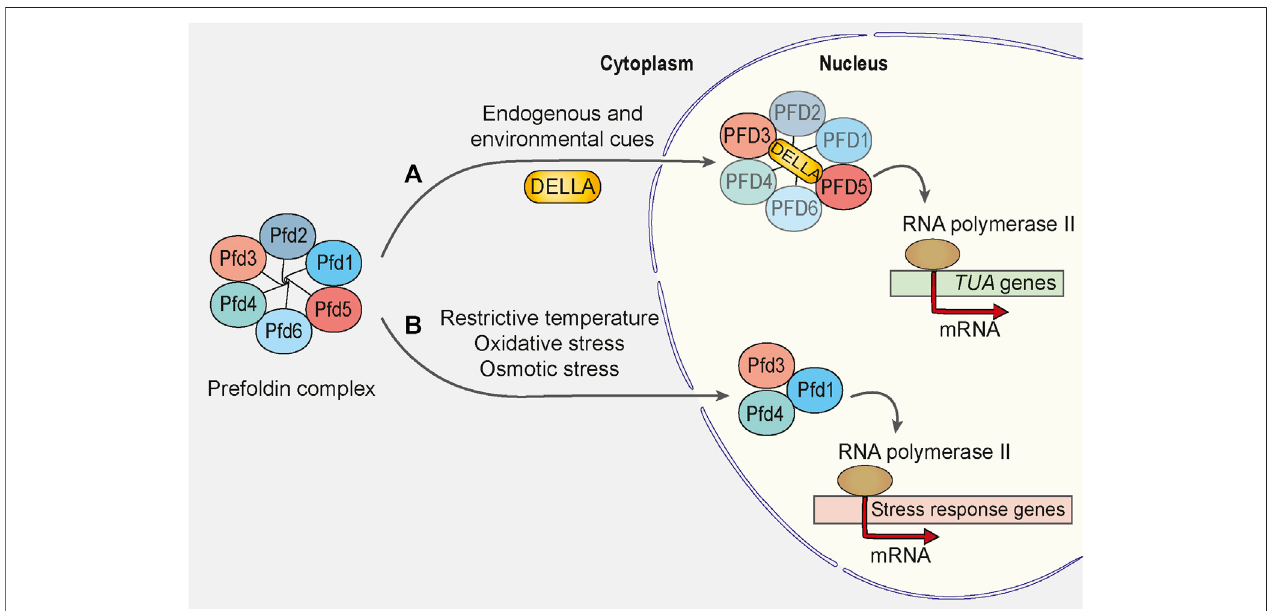
FIGURE 3 | Prefoldin complex is involved in transcriptional regulation upon cellular stress. (A) In Arabidopsis , endogenous and environmental stimulators control the growth rate of a plant by inducing the DELLA-mediated accumulation of prefoldin complex in the cell nucleus. PFD3 and PFD5 interact directly with DELLA, but integrity of the prefoldin complex during the translocation remains unaffected. In the nucleus, prefoldin complex or some of its subunits activate the transcription of α - tubulin encoding genes ( TUA ). (B) In response to exposure of yeast Saccharomyces cerevisiae to stress stimuli such as restrictive temperature, oxidative and osmotic stress, Pfd1, Pfd3 and Pfd4 subunits localize to the nucleus to facilitate the transcription elongation of some stress-response genes. Pfd1, Pfd3 and Pfd4 may formadistinctcomplexfromthehexamericprefoldincomplexbecausetheabsenceofotherprefoldinsubunitsandconsequentdisruptionoftheprefoldincomplexdoes not suppress the stress response in S. cerevisiae